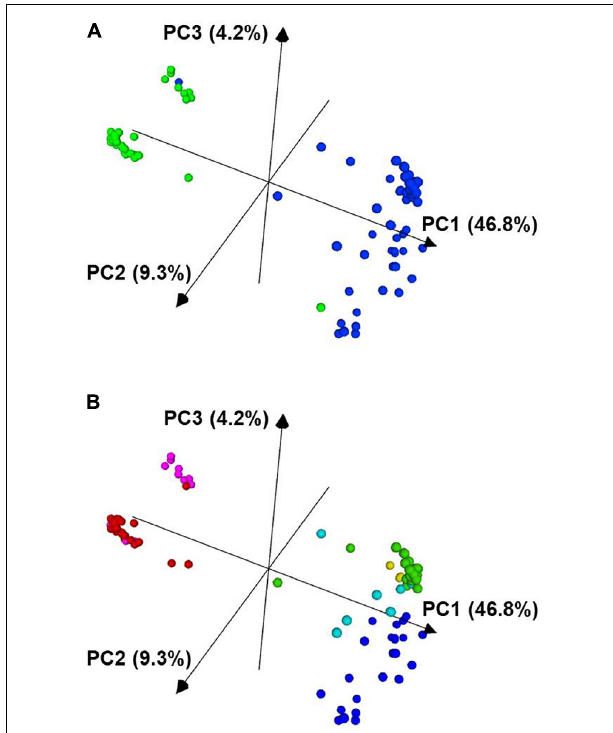
FIGURE 4 | Principal component analysis of 96 P. vulgaris accessions based on 2,522 SNP markers. In panel (A) , the Mesoamerican accessions are colored blue and the Andean accessions are colored green. In panel (B) , the accessions are colored based on the K groups from Supplementary Figure 2 and Figure 3 . The PCA plot was visualized with CurlyWhirly (Milne et al., 2014). PC1, the first principal component; PC2, the second principal component; PC3, the third principal